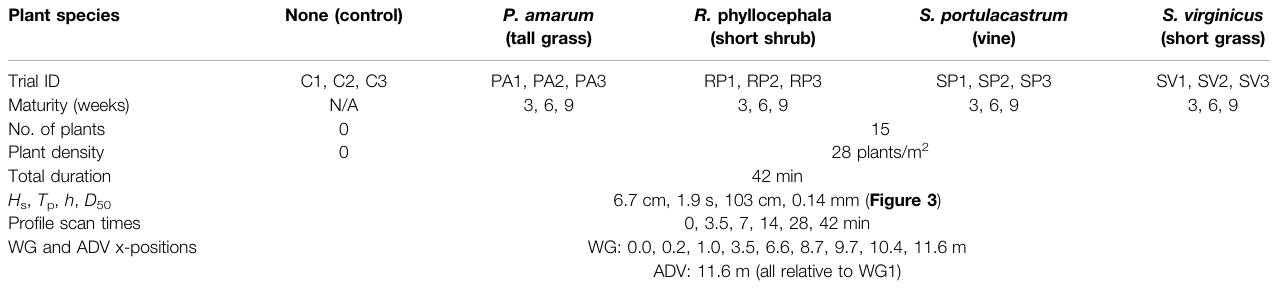
TABLE 1 | Summary of wave fl ume experiment parameters. Plant